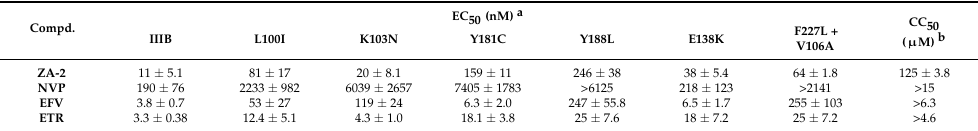
Table 1. Anti-HIV-1 activity and cytotoxicity of ZA-2 . Compd.